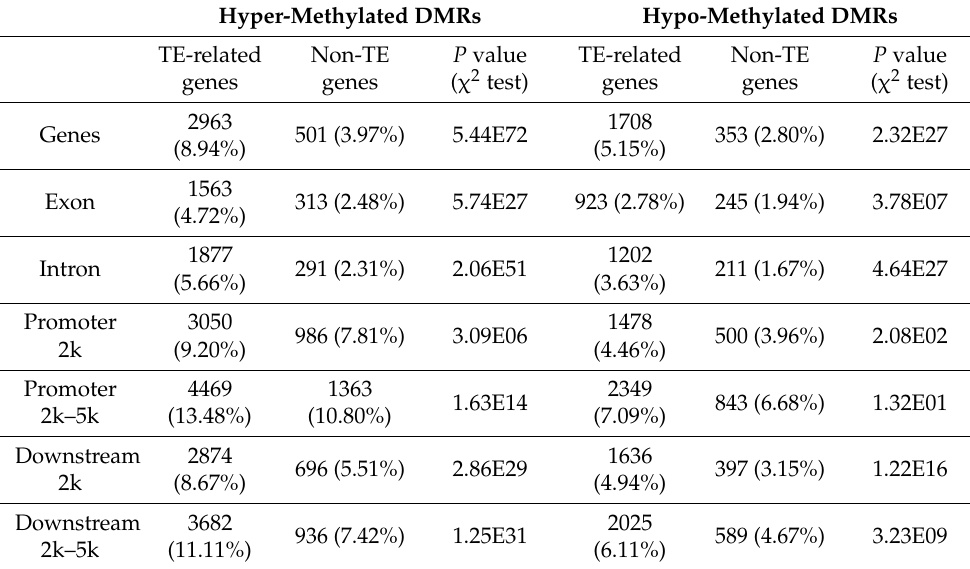
Table 1. The number and proportion of genes with altered DNA